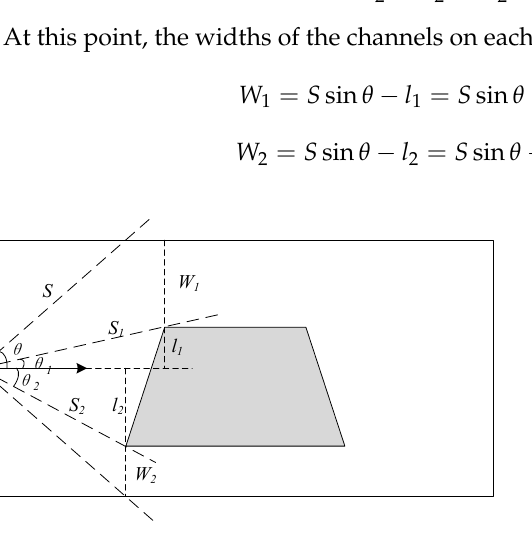
Figure 8. Road obstruction in front of the UGVs fleet.